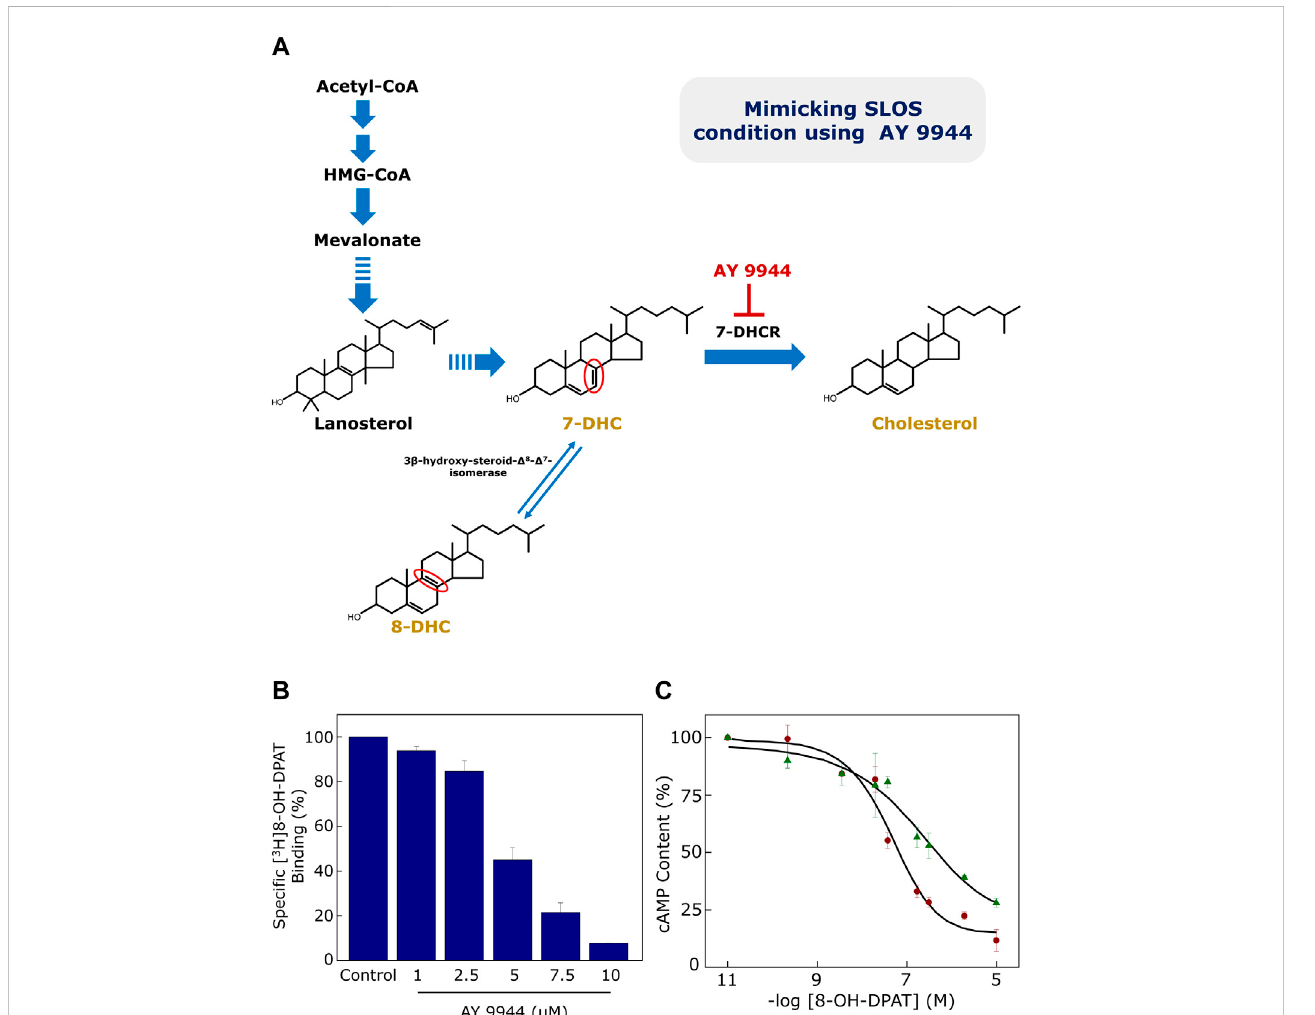
FIGURE 4 (A) Generation of a cellular model of SLOS using AY 9944, a speci fi c metabolic inhibitor of 7-DHCR, the enzyme that reduces the Δ 7 double bond in 7- DHC in the last step of the Kandutsch-Russell pathway of cholesterol biosynthesis (see Figures 1, 2). Mutations in 7-DHCR cause SLOS. Reduced levels of cholesterol, accompanied with elevated levels of dehydrocholesterol (7-DHC + 8-DHC), are characteristic of SLOS. 8-DHC, a positional isomer of 7-DHC, is formed due to an enzyme-catalyzed isomerization of 7-DHC. The only difference between 7-DHC (and 8-DHC) and cholesterol is the double bond at the 7th (or 8th) position in the sterol ring (highlighted in their chemical structures in red). Ligand binding and cellular signaling of the serotonin 1A receptor is affected in the cellular model of SLOS (see (B) and (C) below). (B) CHO cells stably expressing the serotonin 1A receptor were treated with increasing concentrations of AY 9944 and speci fi c [ 3 H]8-OH-DPAT binding was measured. Ligand binding activity of the serotonin 1A receptor exhibited a progressive reduction with increasing concentrations of AY 9944. (C) Downstream signaling in the cellular model of SLOS was determined by measuring cellular cAMP levels.Theserotonin 1A receptorisnegativelycoupledtoG-proteins(Gi)andthereforeleadstoreductionincellularcAMPleveluponstimulationwithagonists. Data represent changes in cellular cAMP level in control (maroon circles) cells and cells treated with 5 μ M AY 9944 (green triangles) with increasing concentrations of 8-OH-DPAT. Adapted and modi fi ed from Paila et al. (2008) with permission from Elsevier. See text for more